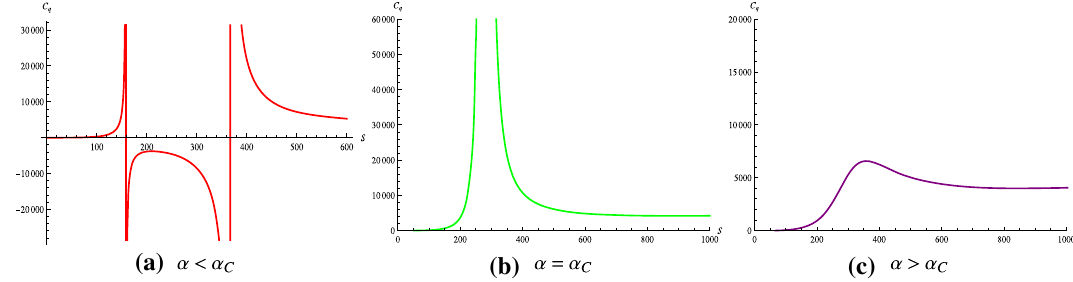
Fig. 6 The figure shows C α vs S for different charges α for the neutral Gauss–Bonnet AdS black hole. Here parameter l =